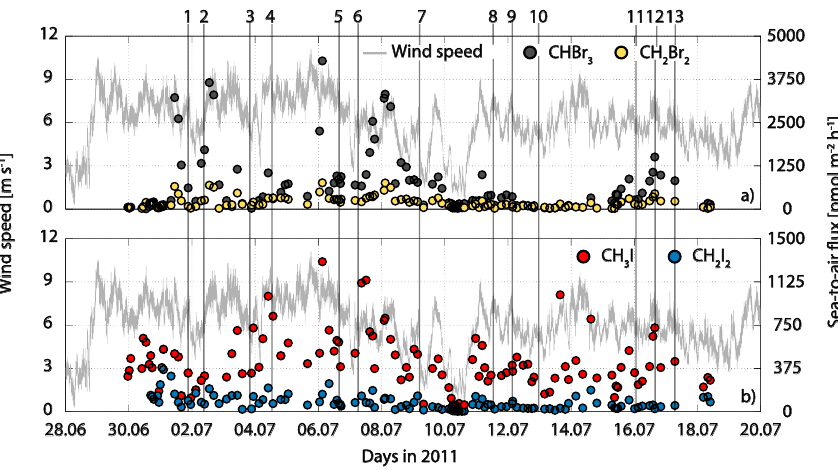
Figure 6. Wind speed during the cruise and sea-to-air fluxes calculated with sea surface water concentrations and mean atmospheric halo- carbon data (a) CHBr 3 and CH 2 Br 2 and (b) CH 3 I and CH 2 I 2 . Numbers on the top indicate CTD